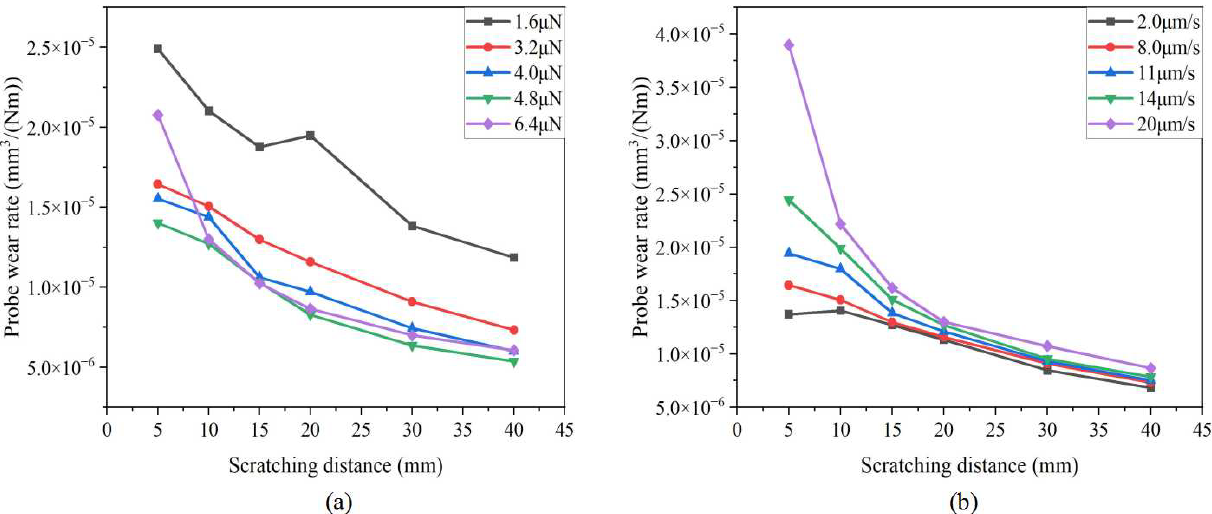
Figure 8. Relationship between scratching distance and probe wear rate: ( a ) different normal load levels; ( b ) different scratching speed levels .